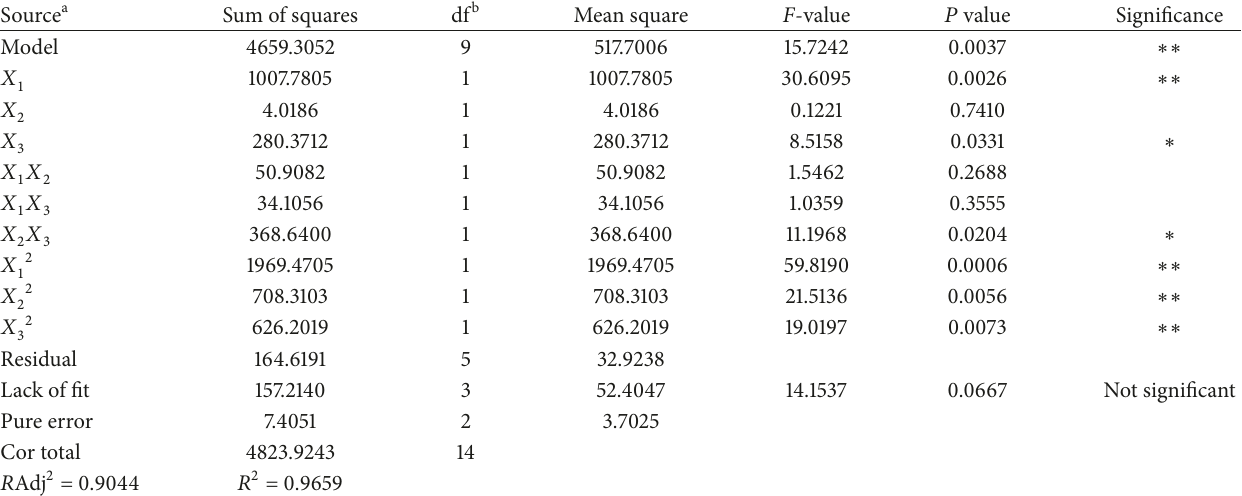
Table 2: Estimated regression coefficients for quadratic polynomial model and ANOVA for the experimental results.